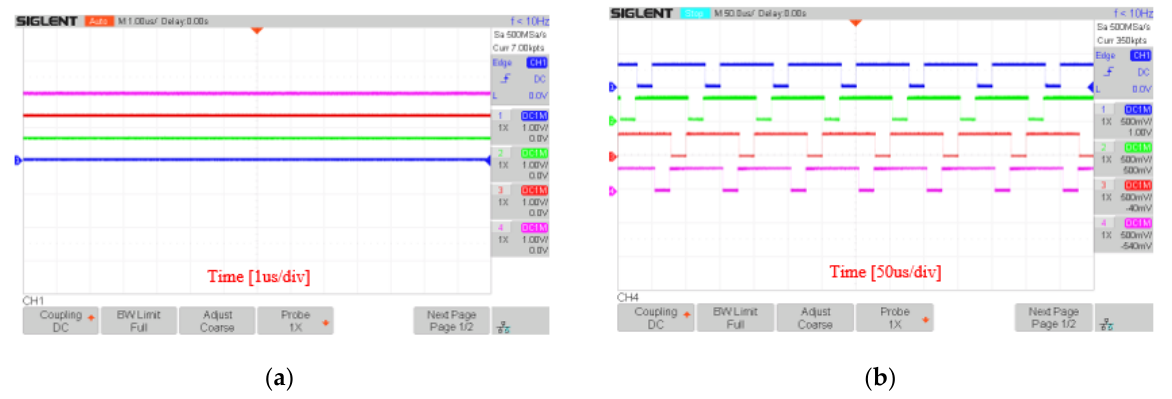
Figure 31. Experimental result of four interleaved carriers using DSA-PSC method, ( a ) carrier phases; ( b ) PWM control signals.